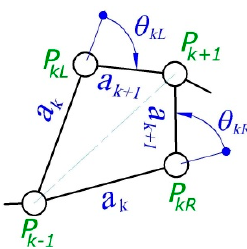
Figure 4. ( a ) Left-hand relative configuration L between two links of a serial robot. ( b ) Intervals in which the angle 𝜃 (cid:3038) changes in the left-hand configuration represented on a numerical axis.